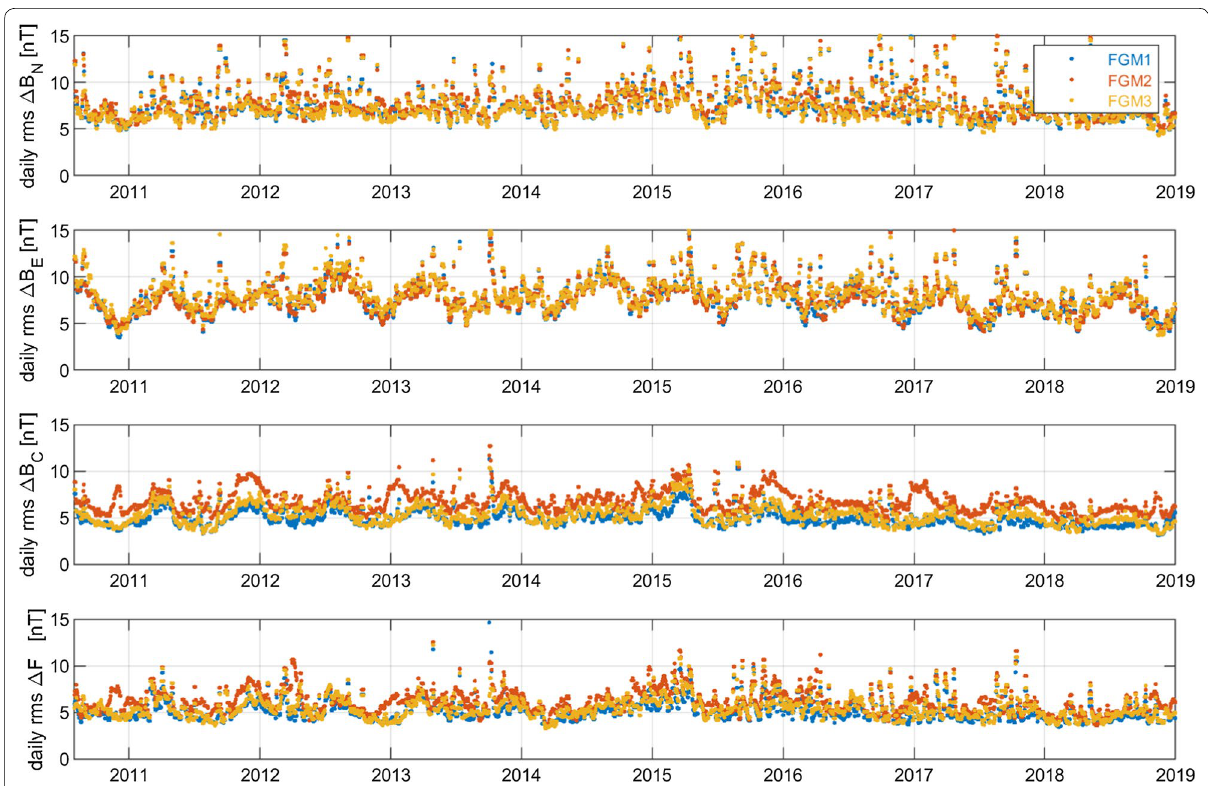
B B obs − mod at non‑polar latitudes for the three vector components in the NEC frame and for scalar intensity =